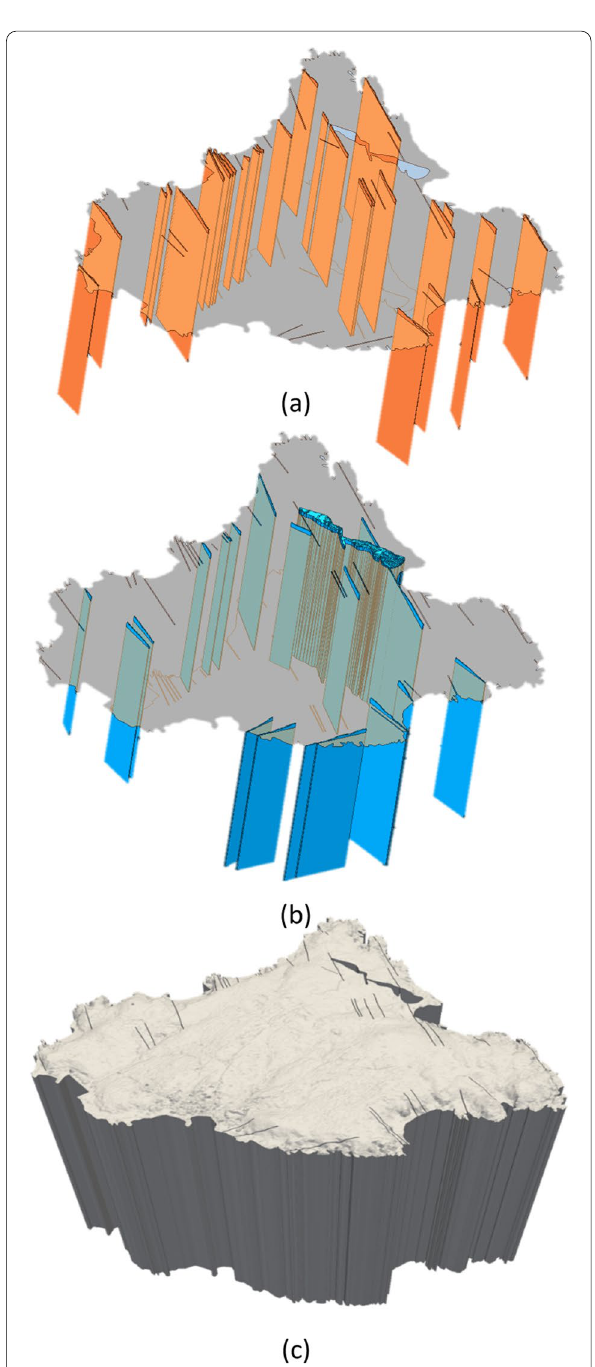
Fig. 7 Rock units used in Huayu’s geological model: a 3D dacite dikes, b 3D rhyolite dikes, and c andesite lava flow without